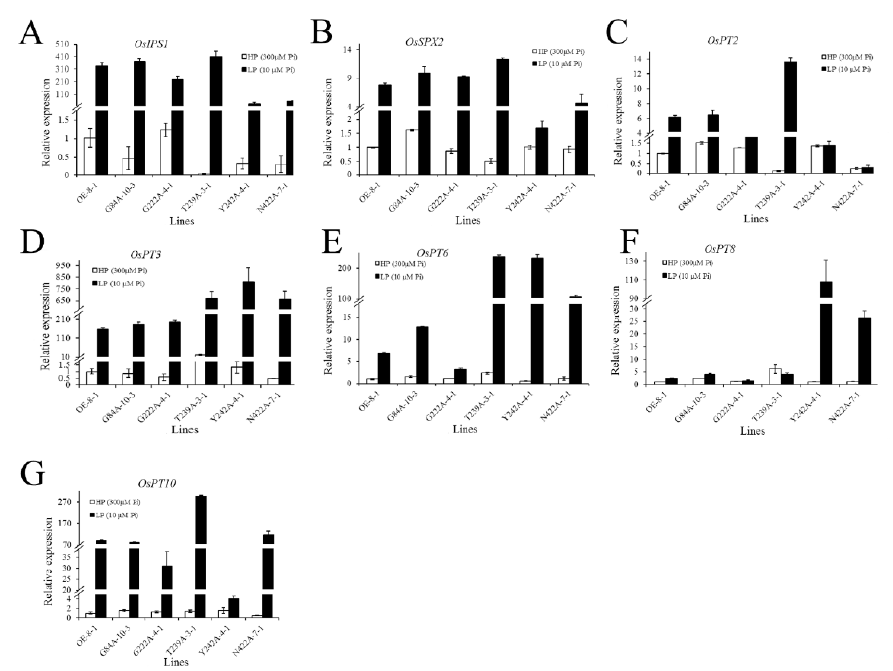
Figure 10. The relative expression analysis of Cmphts and other PSR gene under different phosphate conditions. Relative expression analysis of OsIPS1 ( A ), OsSPX2 ( B ), OsPT2 ( C ), OsPT3 ( D ), OsPT6 ( E ), OsPT8 ( F ), and OsPT10 ( G ) between CmPT2 -OE and Cmphts-OE lines under different phosphate conditions.